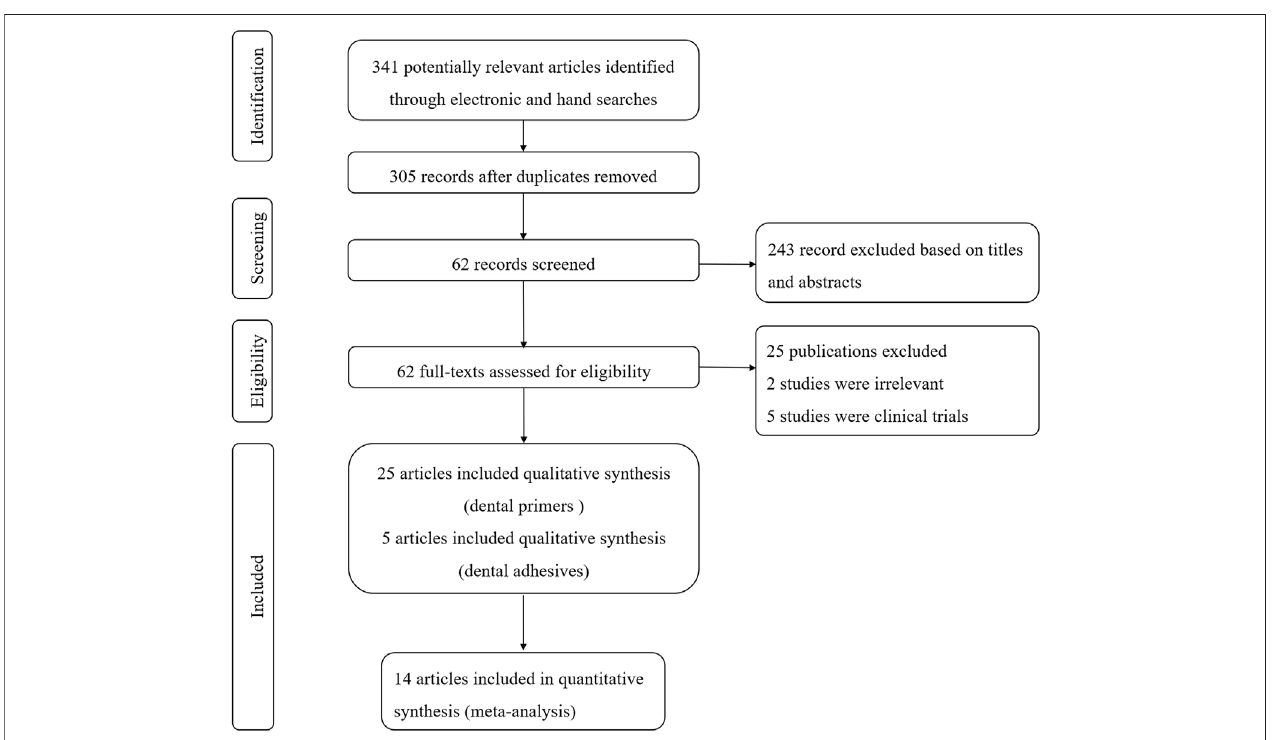
FIGURE 1 | Flow chart of study selection according to PRISMA